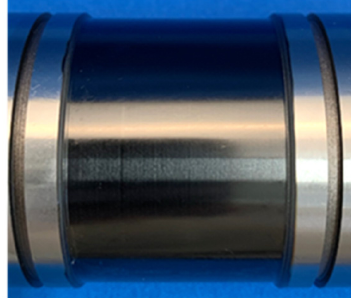
Figure 5. DLC-coated journal. Table 4. a-C:H:Si coating specifications.